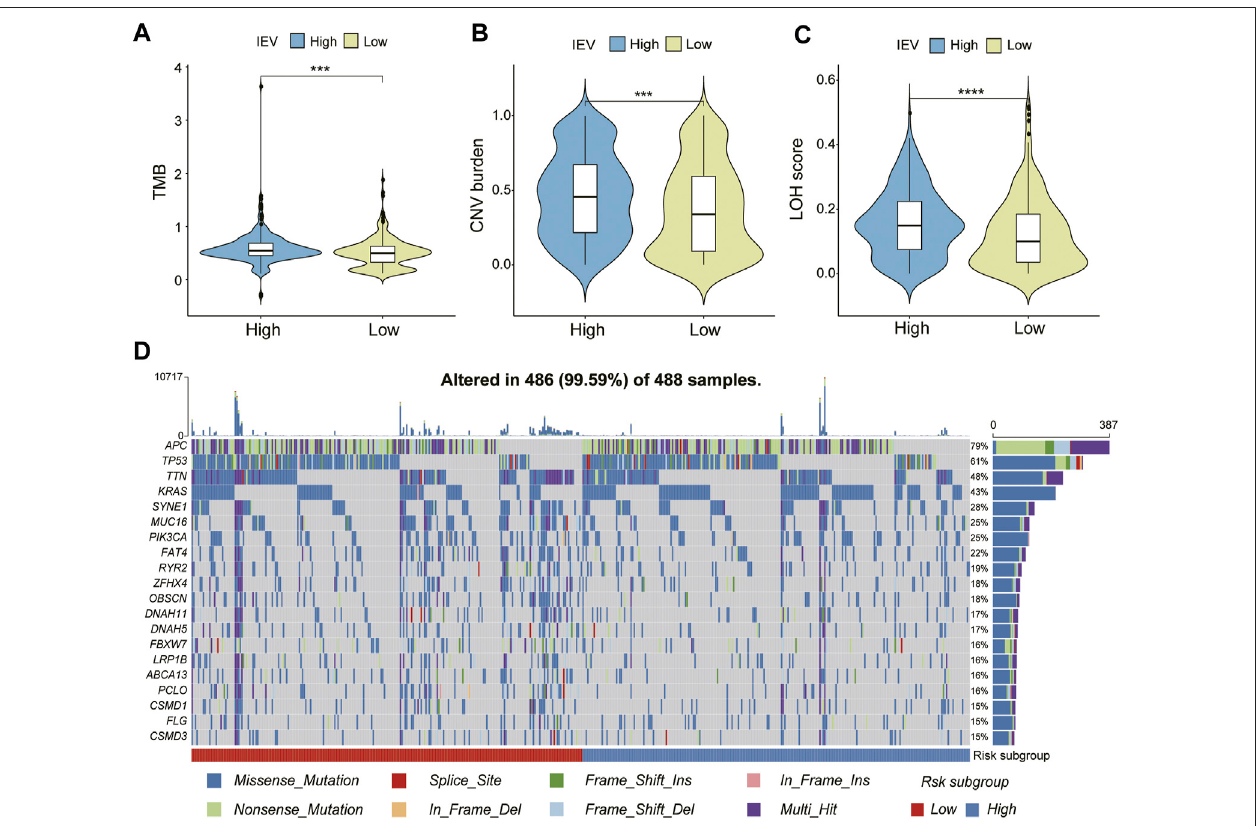
FIGURE 7 | Genomic alteration and somatic mutation analysis in the Cancer Genome Atlas cohort. (A – C) tumor mutation burden, copy number variation burden, and loss of heterozygosity score were compared between low- and high-risk subgroups. (D) somatic mutation landscape of top 20 frequent SMGs between low- and high-risk CC